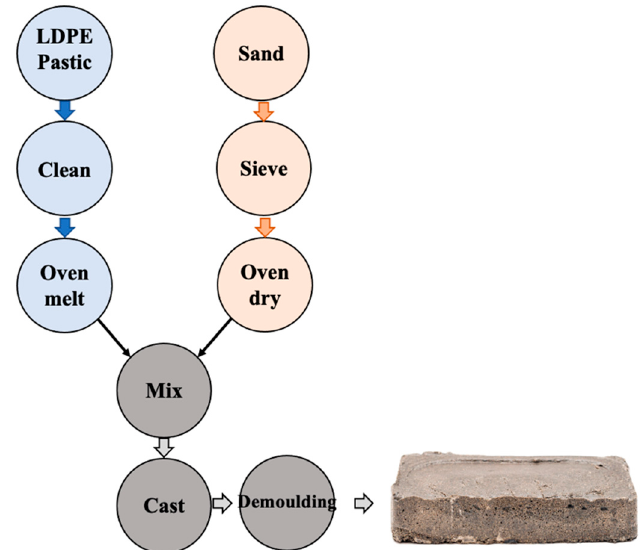
Figure 3. Flow diagram for plastic sand cobbles manufacturing.